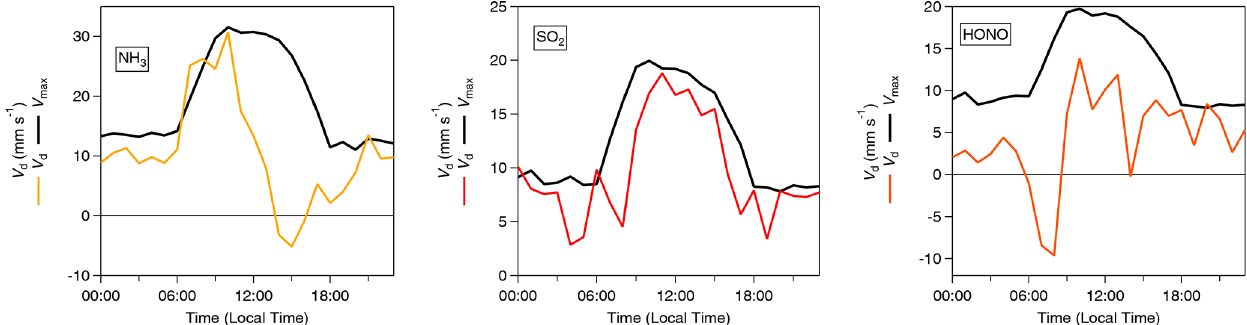
Figure 6. Inorganic trace gas deposition velocities ( V d ) (post-correction values) with γ F (Chor et al., 2017) and calculated theoretical maximum deposition velocities ( V max ) for NH 3 , SO 2 and